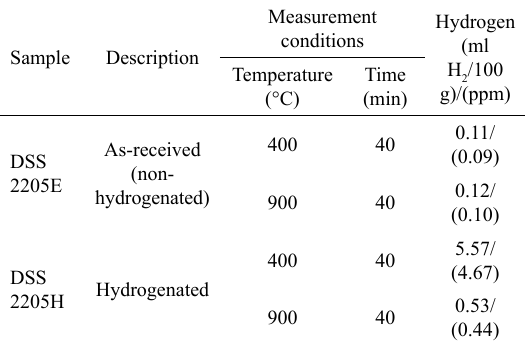
Figure 1. Schematic view of the tensile test samples; measurements in Table 2. Measurements of diffusible and residual hydrogen.